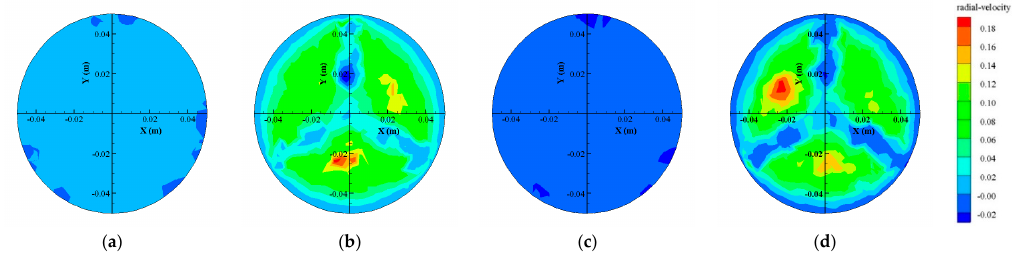
Figure 10. Radial flow velocity distributions of the upstream sections of capsules. ( a ) Z = 0.105 m, L/D = 2; ( b ) Z = 0.075 m, L/D = 2; ( c ) Z = 0.105 m, L/D = 1.67; ( d ) Z = 0.075 m, L/D = 1.67. L / D = 2; ( b ) Z = 0.075 m, L / D = 2; ( c ) Z = 0.105 m, L / D = 1.67; ( d ) Z = 0.075 m, L / D = 1.67.